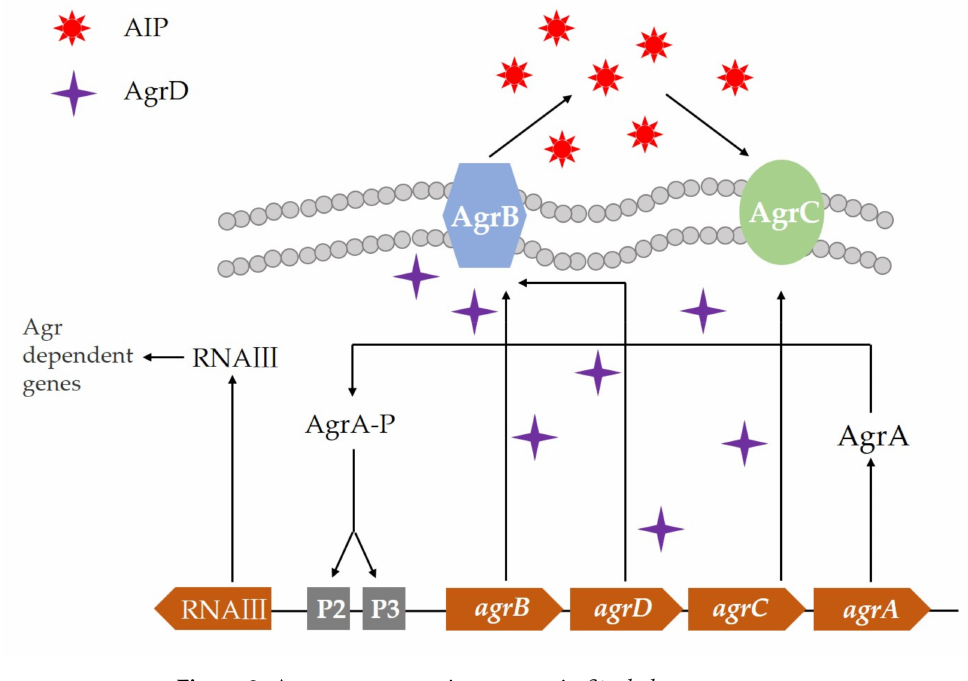
Figure 2. Agr quorum-sensing system in Staphylococcus aureus .